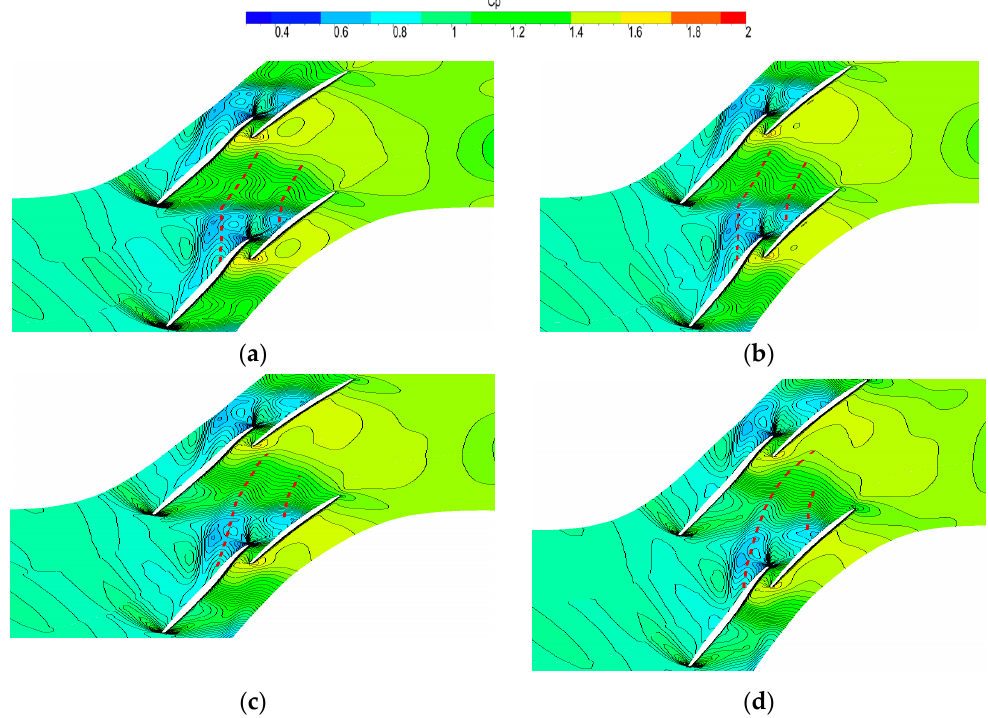
Figure 13. Contrast diagram of the static pressure coefficient near the casing wall of NB10, NB20, and NB30. ( a ) ORG. ( b ) NB10. ( c ) NB20. ( d ) NB30.